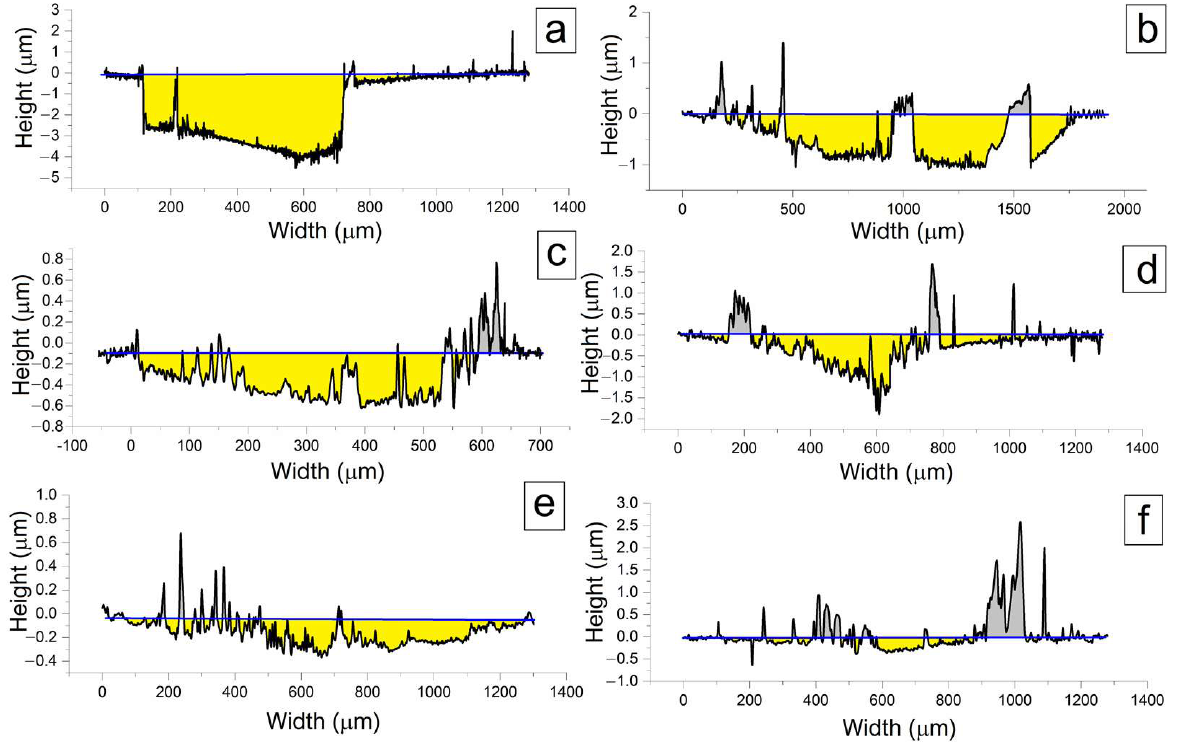
Figure 9. The wear track profiles on ZrN ( a ), CrN ( b ), ZrCrN(0.5) ( c ), ZrCrN(3.5) ( d ), ZrCrN(5) ( e ) and ZrCrN(8) ( f ) after sliding at 6Н.